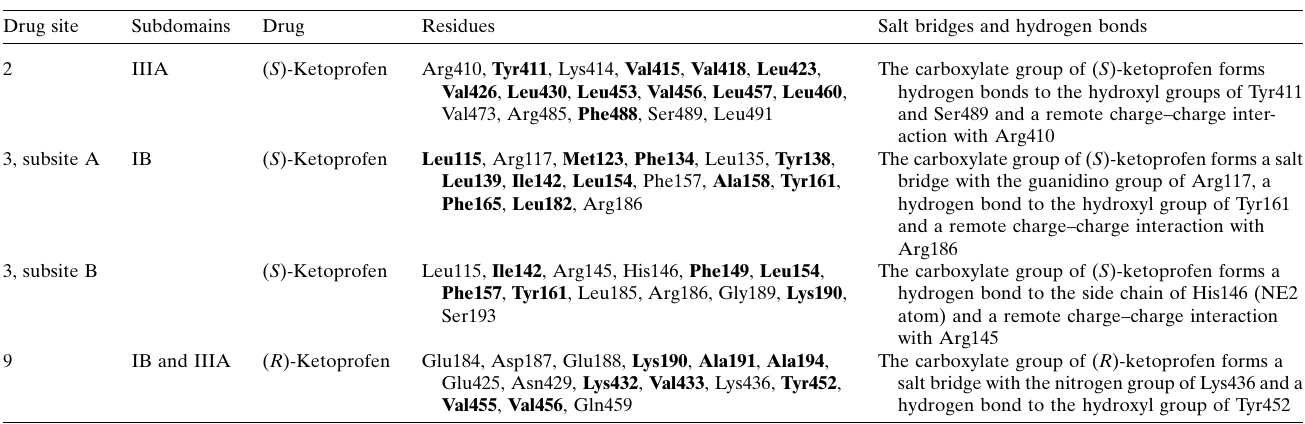
Table 2 The residues that participate in the binding of ketoprofen to HSA and the hydrophilic interactions observed in ketoprofen binding sites. Residues shown in bold provide a major hydrophobic contribution to drug